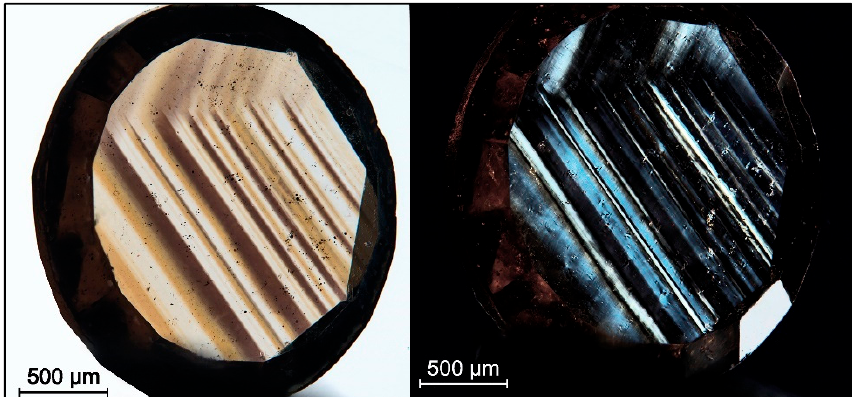
Figure 4. A very low CO 2 content diamond (sample SGDF 5846), representing the limit between CO 2 and “Pseudo CO 2 ”, in immersion ( left ) and under crossed polarizing filters ( right ). The amazing “zebra” layering of the diamond did not relate to plastic deformation. The lighter yellow brown and the darker brown zones were apparently isotropic—they stayed dark during rotation of the sample—while the colorless and olive-gray zones were clearly anisotropic—they lightened up and turn dark alternating every 45°; the olive-gray zones showed this effect most strongly and appear white in the image above on the right.